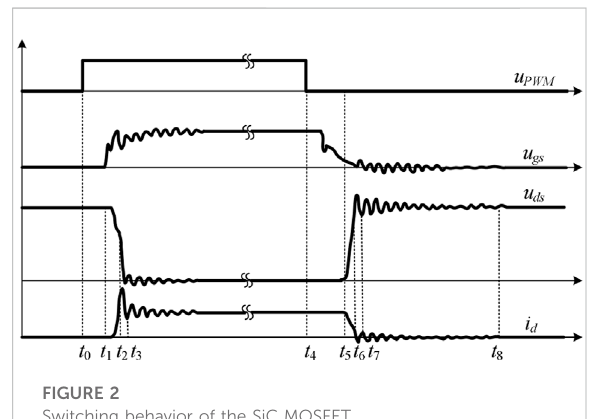
FIGURE 2 Switching behavior of the SiC